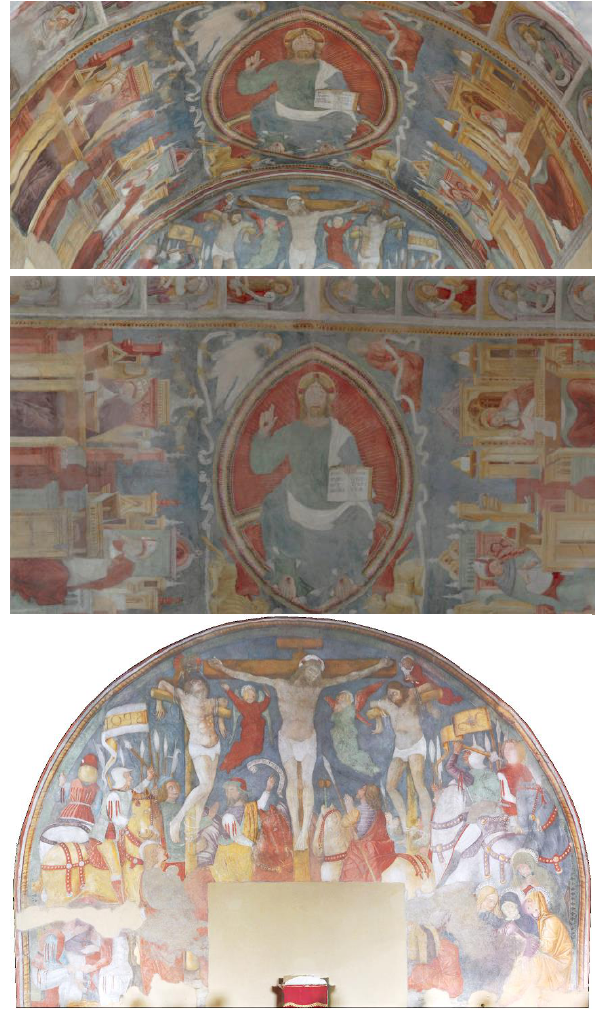
Figure 11. Textured 3D models (top), orthophotos of the unrolled vault (middle) and vertical wall (bottom) generated with a calibrated fisheye